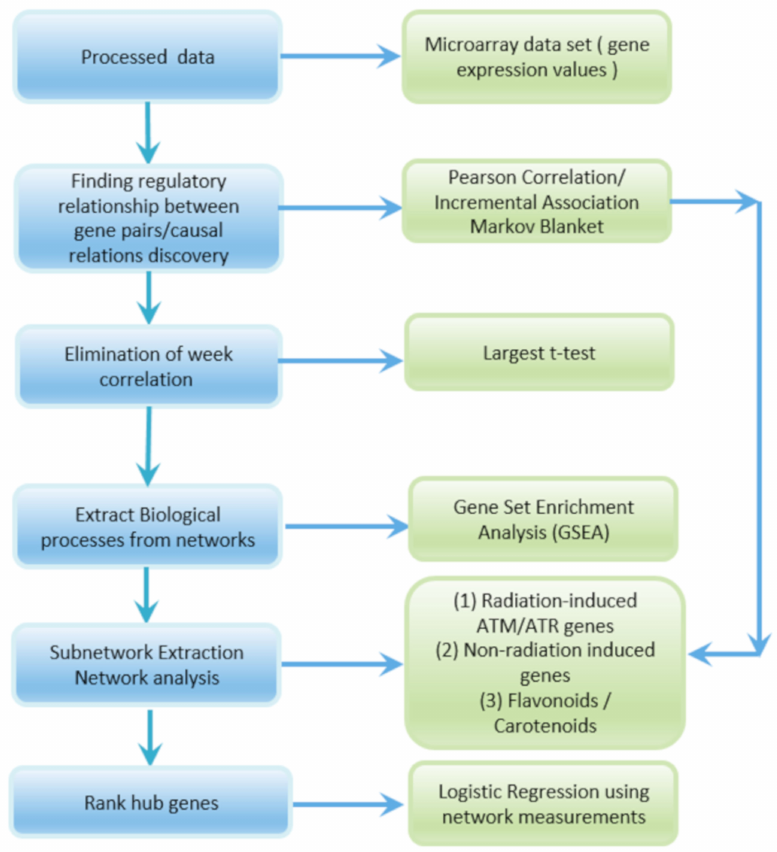
Figure 1. Flow diagram showing the sequence of steps followed for extraction of radiation response subnetworks from the gene expression values in the GLDS datasets and network